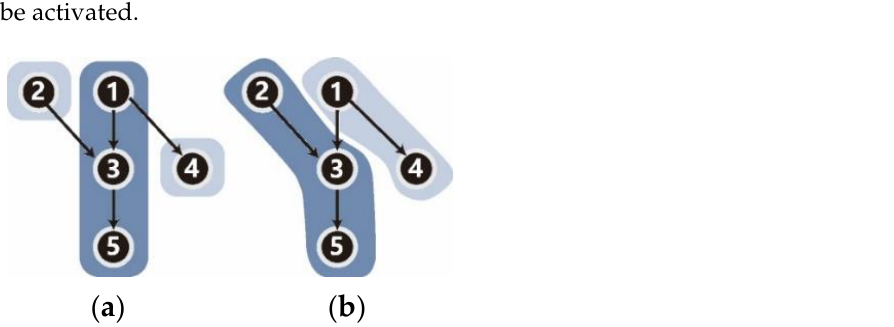
Figure 3. Controllable subspace control range comparison diagram: ( a ) controllable subspace of node 1 and ( b ) controllable subspace of node 1.